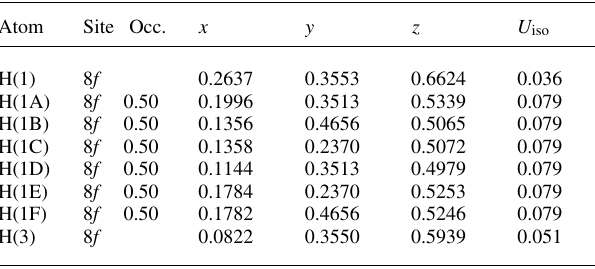
Table 2. Atomic coordinates and displacement parameters (in Å 2 )